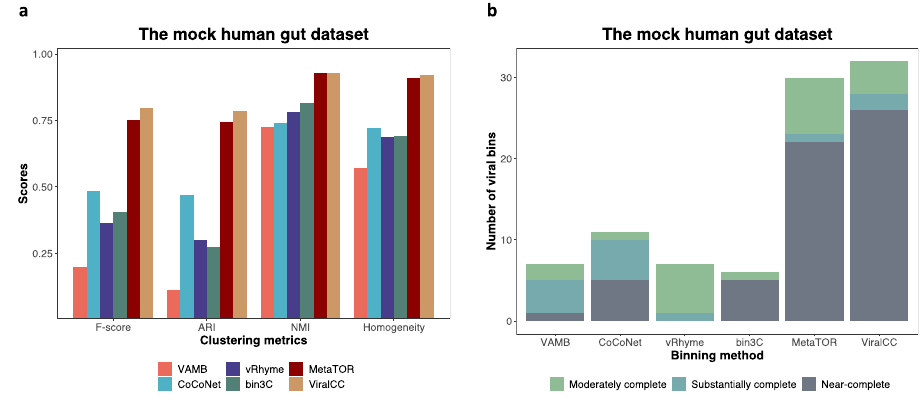
Fig. 2 | ViralCC outperforms other binning methods on the mock human gut dataset. Comparison of viral genome retrieval performance according to ( a ) clustering metrics and ( b ) completeness and contamination criteria (Moderately complete:50% ≤ completeness<70%,contamination ≤ 10%;Substantiallycomplete: